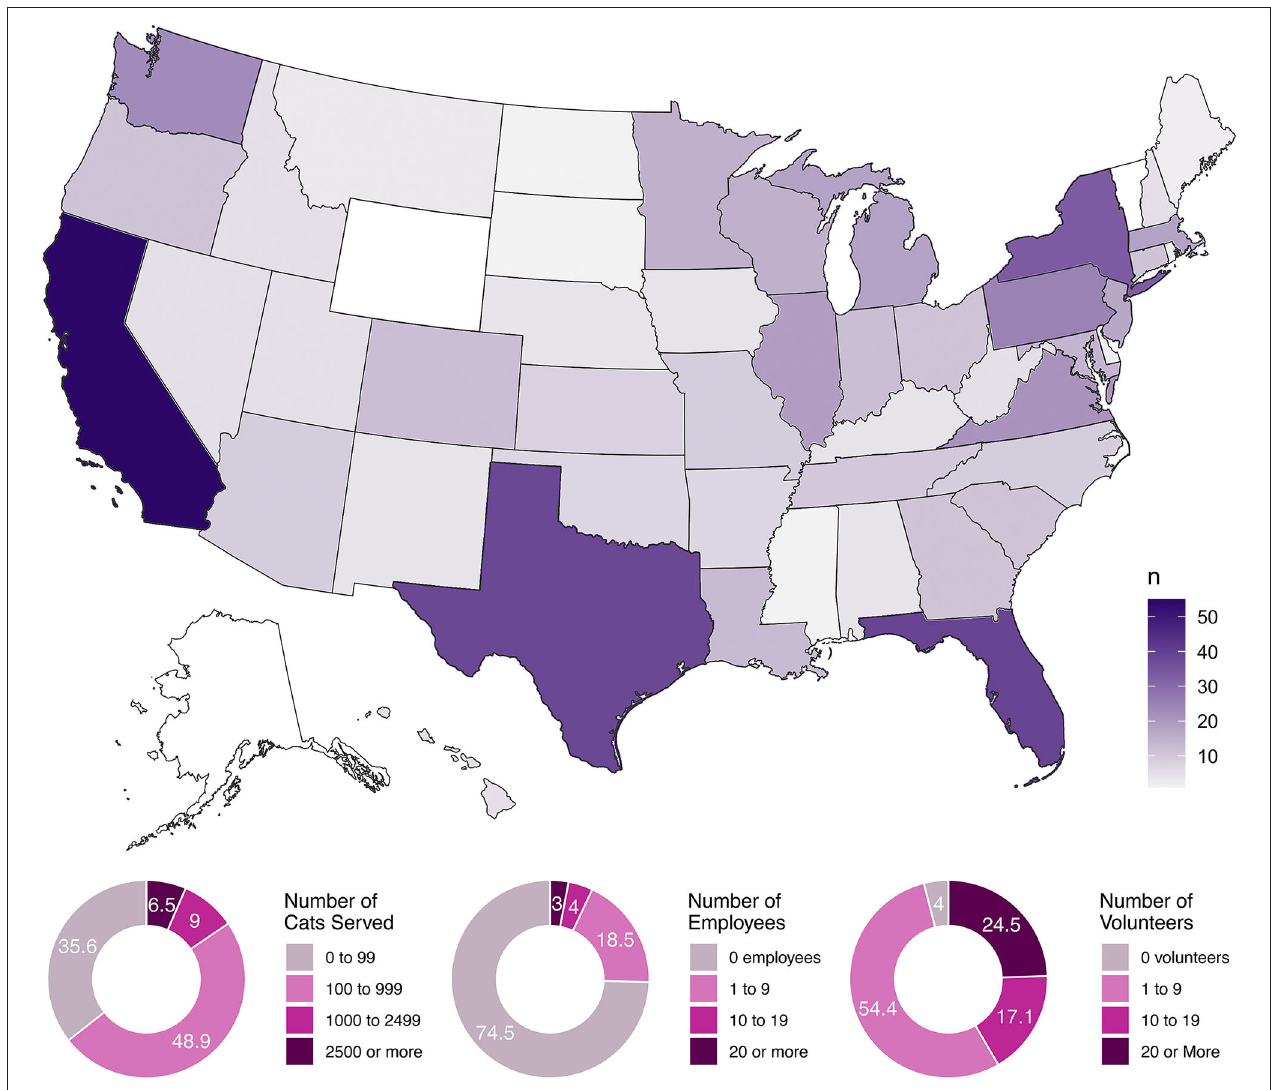
FIGURE 1 | A choropleth map of the United States showing the geographic distribution of our respondent organizations and their basic demographics.